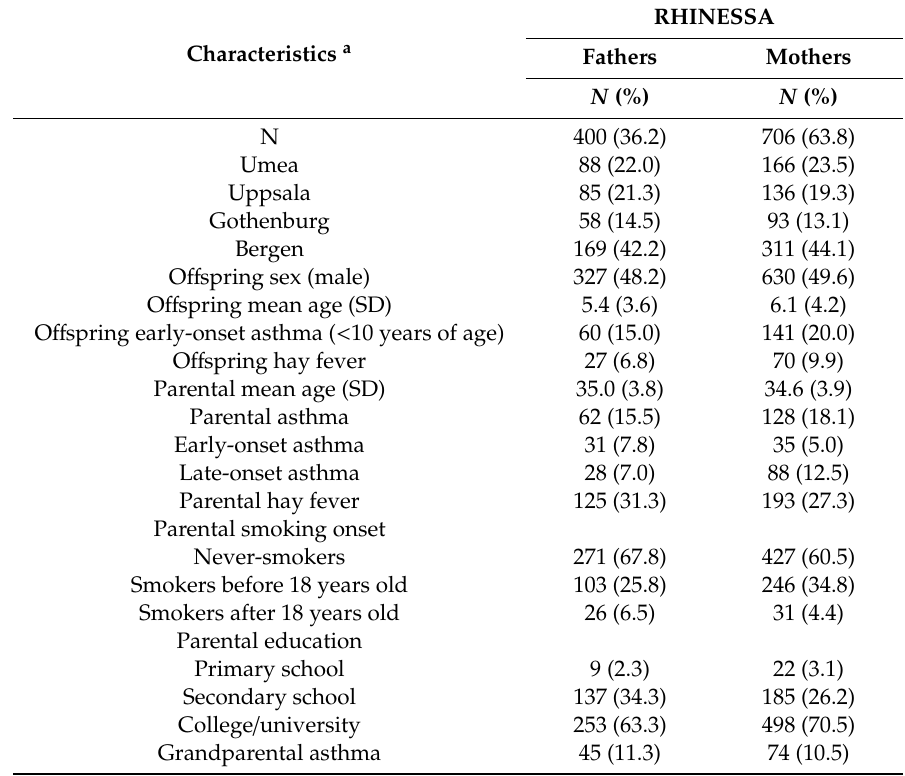
Table 1. Study population characteristics. N = 706 mothers and 400 fathers and their 1949 o ff spring.